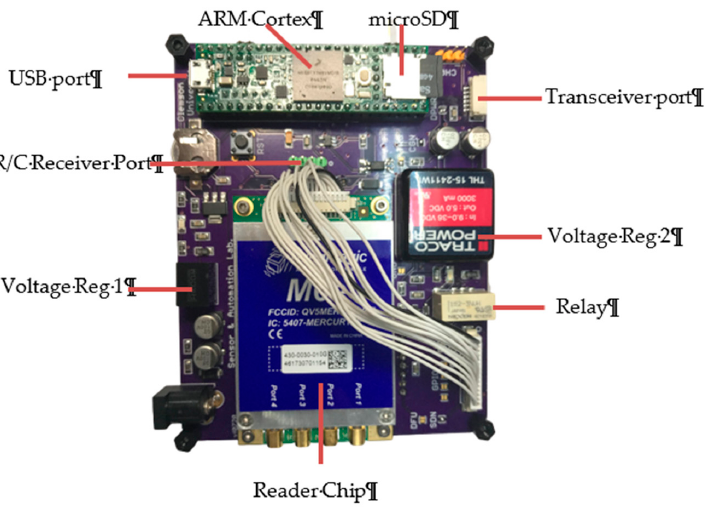
Figure 2. The RFID Reader Module (RFID-RM) with key components labeled.